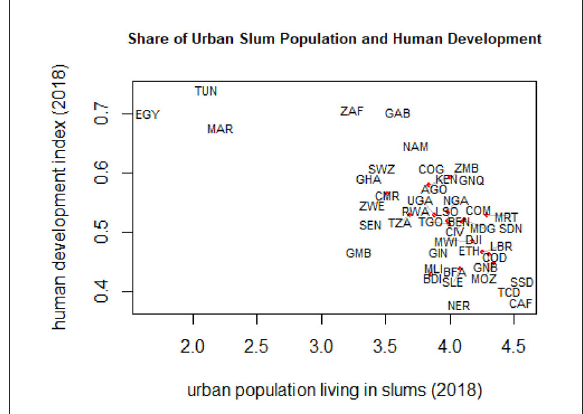
FIGURE3 Share of urban slum population and human development. Source: Scatter plot created by the author from The World Bank Data: